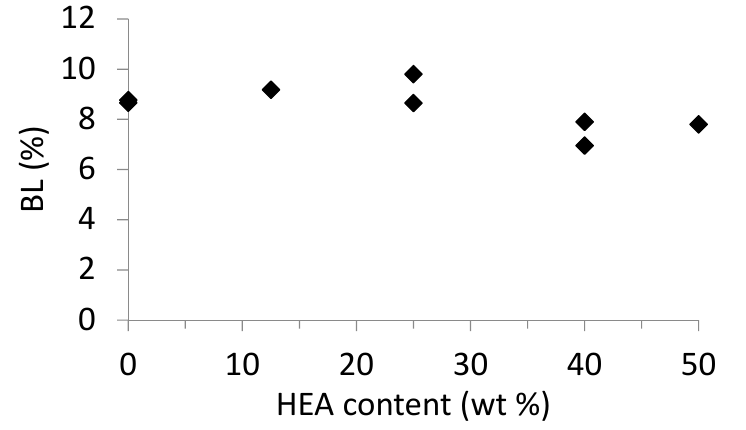
Figure 4. Polymer branching levels (BL) as a function of HEA content (wt %) in the comonomer feed, measured for poly(acrylate) copolymer produced by semi-batch BA/HEA copolymerizations in BPi solvent at 138 °C.